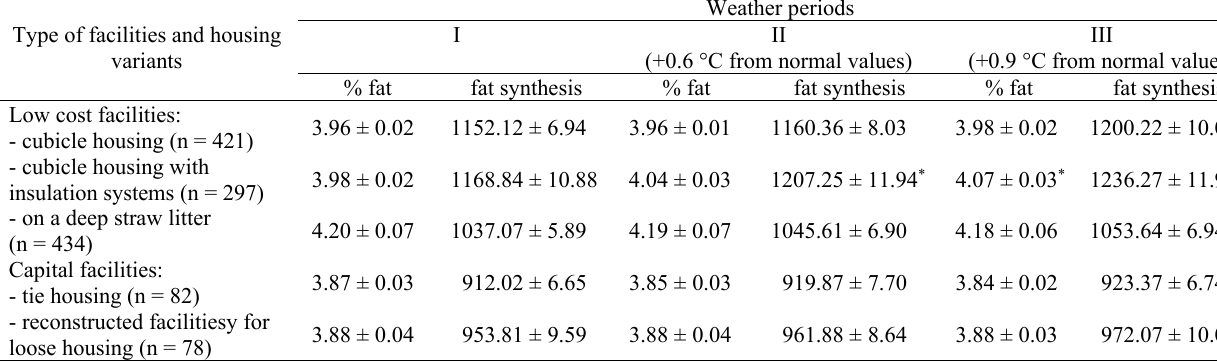
The average mass fraction of fat in cow's milk (%) and its synthesis during research periods, kg/head Type of facilities and housing